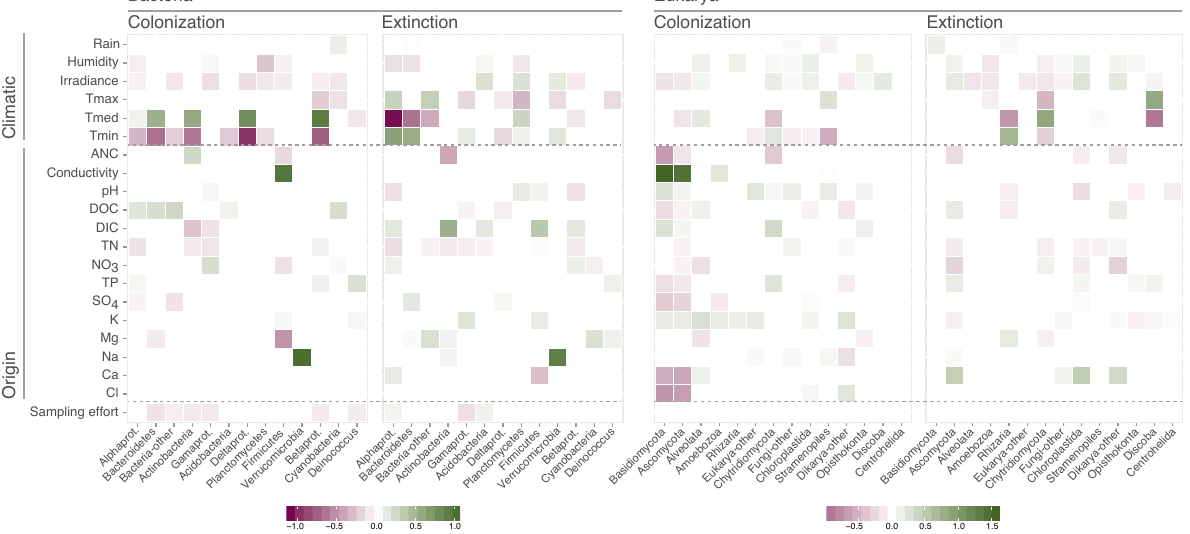
effortClCaNaMgKSO4TPNO3TNDICDOCpHConductivityANCTminTmedTmaxIrradianceHumidityRain Sampling Figure 1. Effect of environmental variables associated with climate or origin (inferred from chemical variables) on colonization and extinction dynamics. The effect is weighted by the logarithm of richness and relative to either colonization or extinction independent terms. Positive values indicate an increase in colonization (or extinction) when a given environmental variable